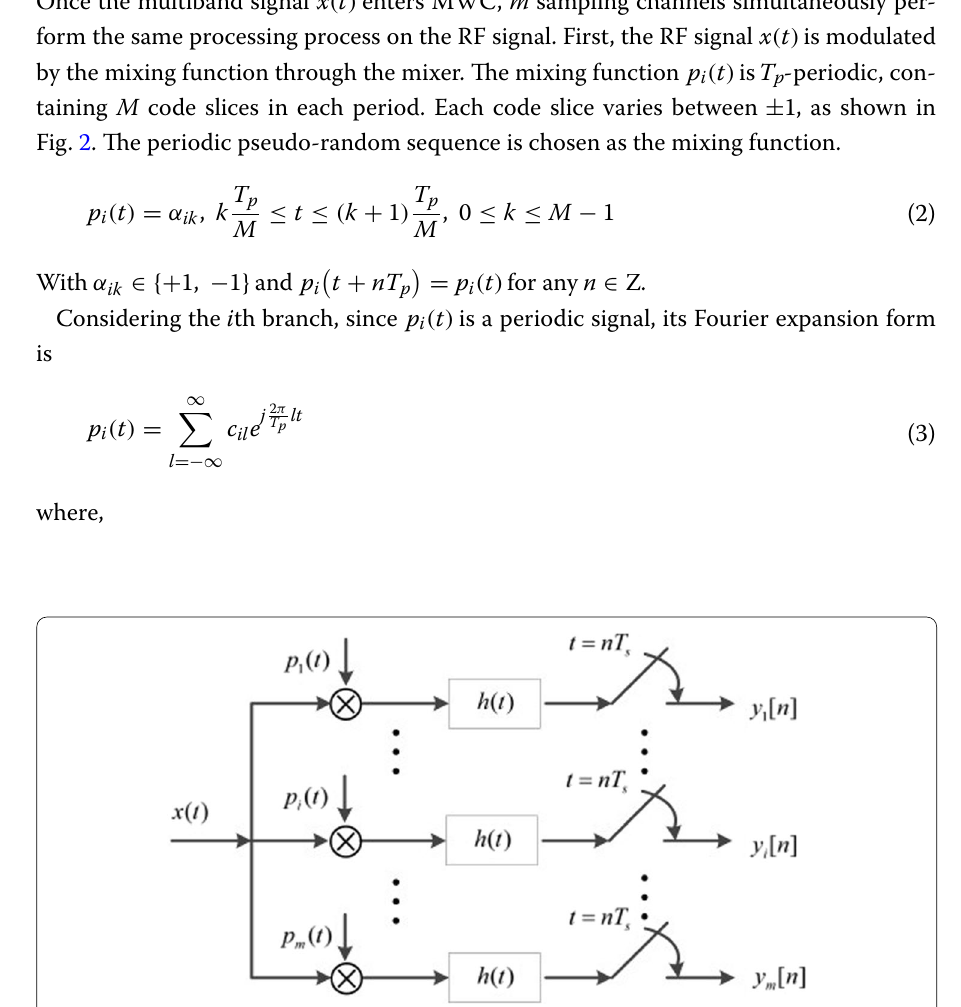
Fig. 1 MWC analog sampling front